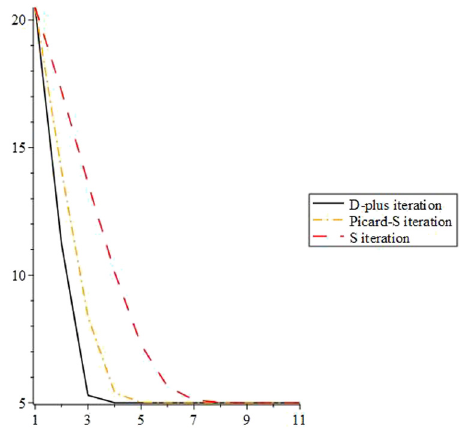
Figure 3: Convergence of D - plus iteration process when initial guess is 0.5.